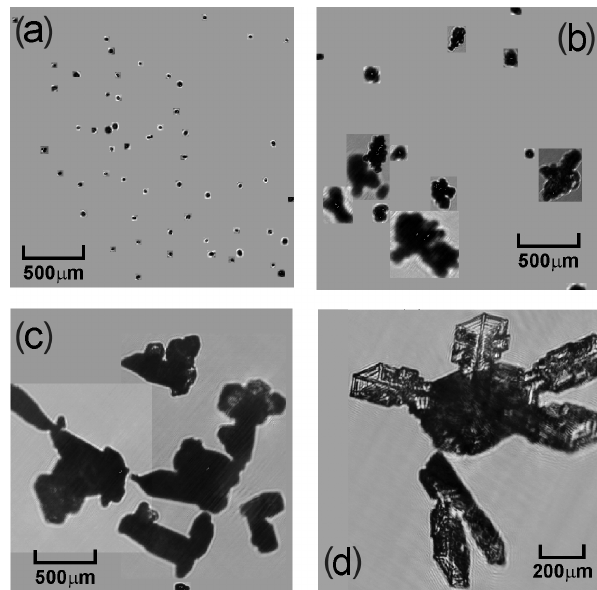
Figure A3. Multiple images registered in 2 . 3mm × 2 . 3mm CPI im- age frames (a, b, c) . Images in panels (a, b) are identified as a result of shattering due to mechanical impact with the CPI inlet. Images in panels (c, d) likely result from fragmentation due to aerodynamic stresses in the CPI inlet tube.